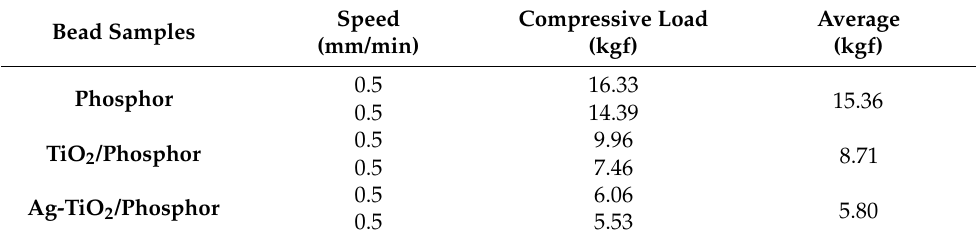
Table 4. Compressive strength averages for Sr 4 Al 14 O 25 :Eu 2+ ,Dy 3+ phosphor beads.